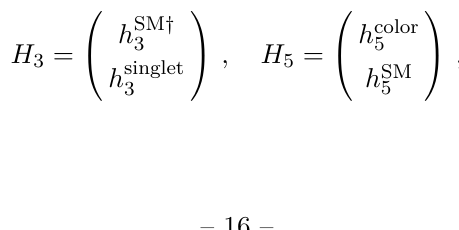
as a function of M X (red solid Ω